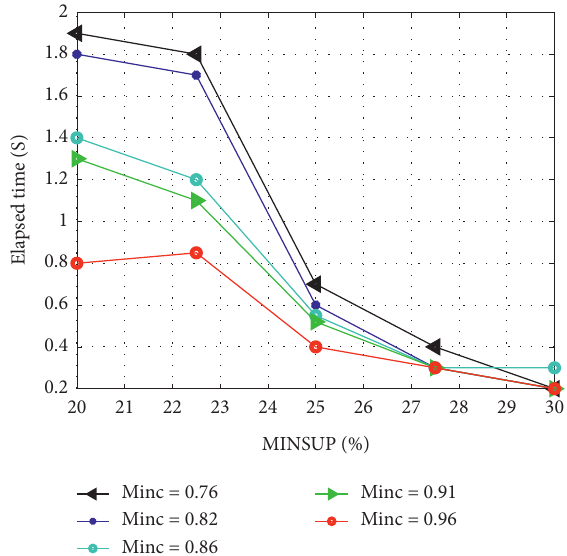
Figure 4: Runtime of the digital art